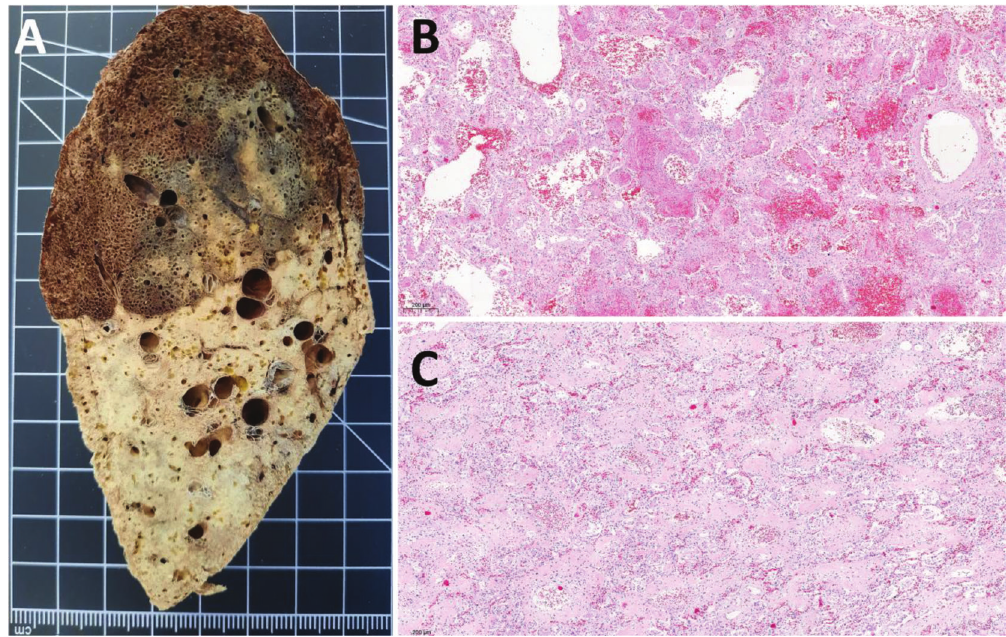
Figure 4 - Female, 42 years old, 38 days of hospitalization and mechanical ventilation. A : Left inferior lung lobe shows marked transition between upper and lower regions, representing two different patterns of lung injury. Upper region corresponds to acute lung injury and lower region to advanced lung remodeling with fibrosis. B : Acute lung injury, with predominance of exudative changes, corresponds to the upper left inferior lobe shown in A . C : Remodeling of lung parenchyma with extensive fibrosis corresponds to the lower left inferior lobe shown in A .